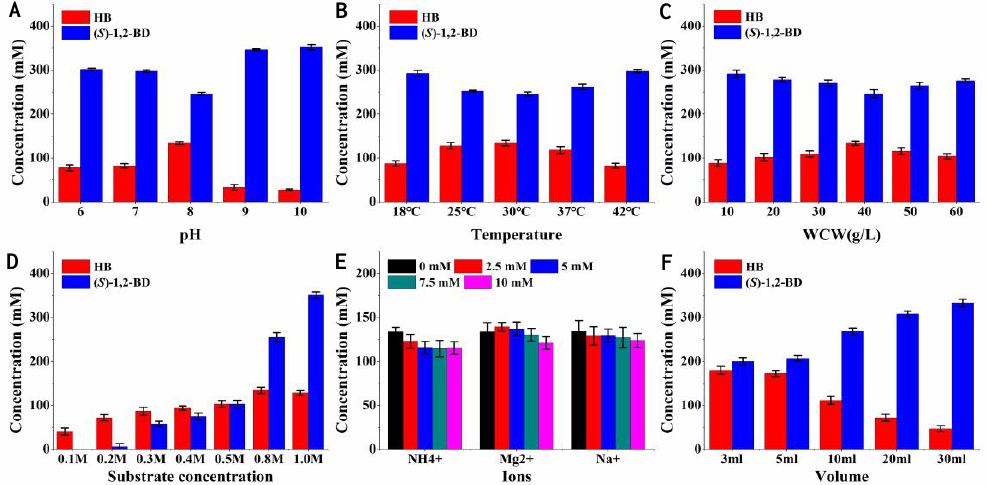
Figure 5. Effects of pH ( A ), temperature ( B ), wet cell weight ( C ), substrate concentration ( D ), ion ( E ), and reaction volume ( F ) on HB production from 1,2-BD mixture by whole cell biocatalyst of E. coli (pET- ssbdh - nox - vgb ).